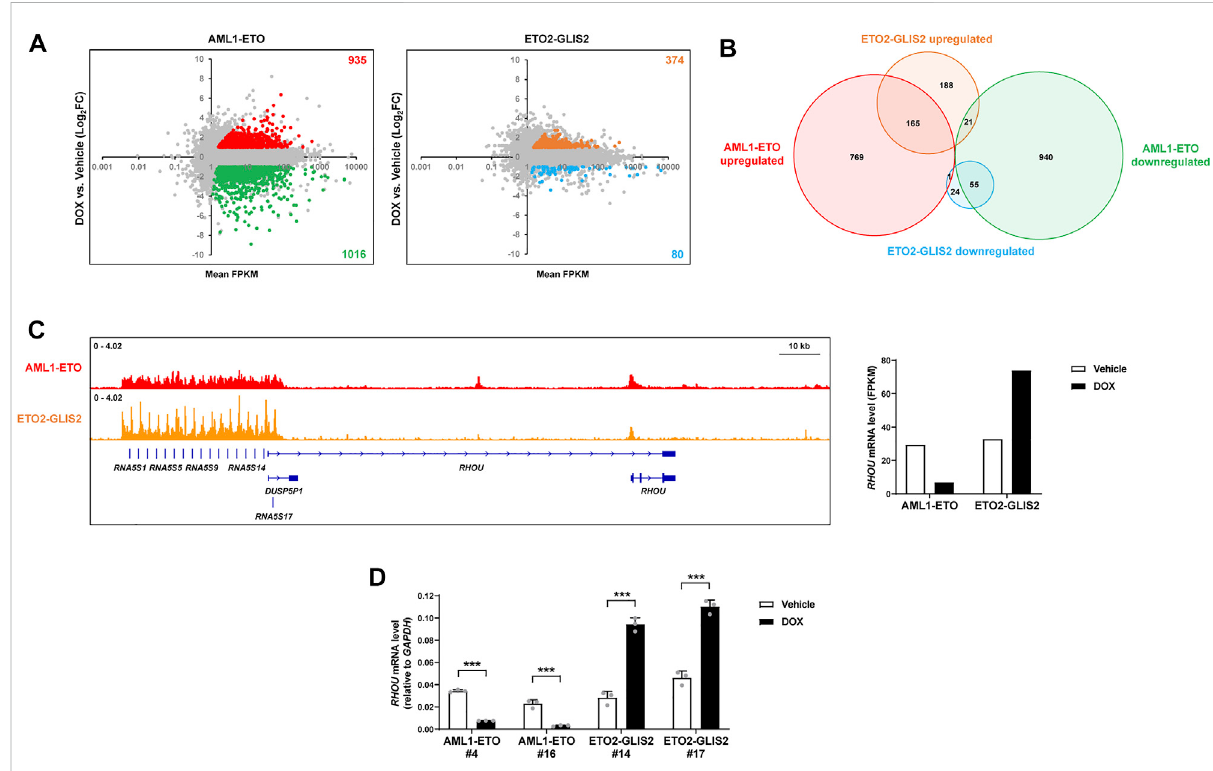
FIGURE 3 RNA-seq analysis of the AML1-ETO and ETO2-GLIS2 regulated genes. (A) Overviews of the expression levels of the genes regulated by AML1- ETOandETO2-GLIS2.ThedotsforeachupregulatedanddownregulatedgenesbyAML1-ETOandETO2-GLIS2inmorethan2-foldarelabelledwith different colors and counted. By using an empty vector-transduced control cell line as a negative control, the genes could be altered by DOX were excludedandlabelledingray.MeanFPKMofthesampleswithandwithoutDOXinductionwasusedtoexcludethegeneswithverylowlevelsof expression. (B) Venn diagram showing the numbers and relationships among the upregulated and downregulated genes by AML1-ETO and ETO2- GLIS2. (C) The RHOU gene as an example of the genes that are differentially regulated by AML1-ETO and ETO2-GLIS2. The ChIP-seq results show that they are both directly bound by AML1-ETO and ETO2-GLIS2, though with slightly but notably different binding patterns. Notably, the promoter regions of the tandem RNA5S1 - RNA5S17 genes (due to space limitation, listed in the fi gure do not include all the gene names) contain multiple G-rich GLIS binding motifs, therefore ETO2-GLIS2 shows repeated sharp peaks. (D) RT-qPCR analysis of the regulated expression of RHOU in independent clone of the cell lines expressing AML1-ETO ( # 4 and # 16) and ETO2-GLIS2 ( # 14 and # 17). Data are presented as means ± SD of three separate experiments; two-tailed t -test; *** p <